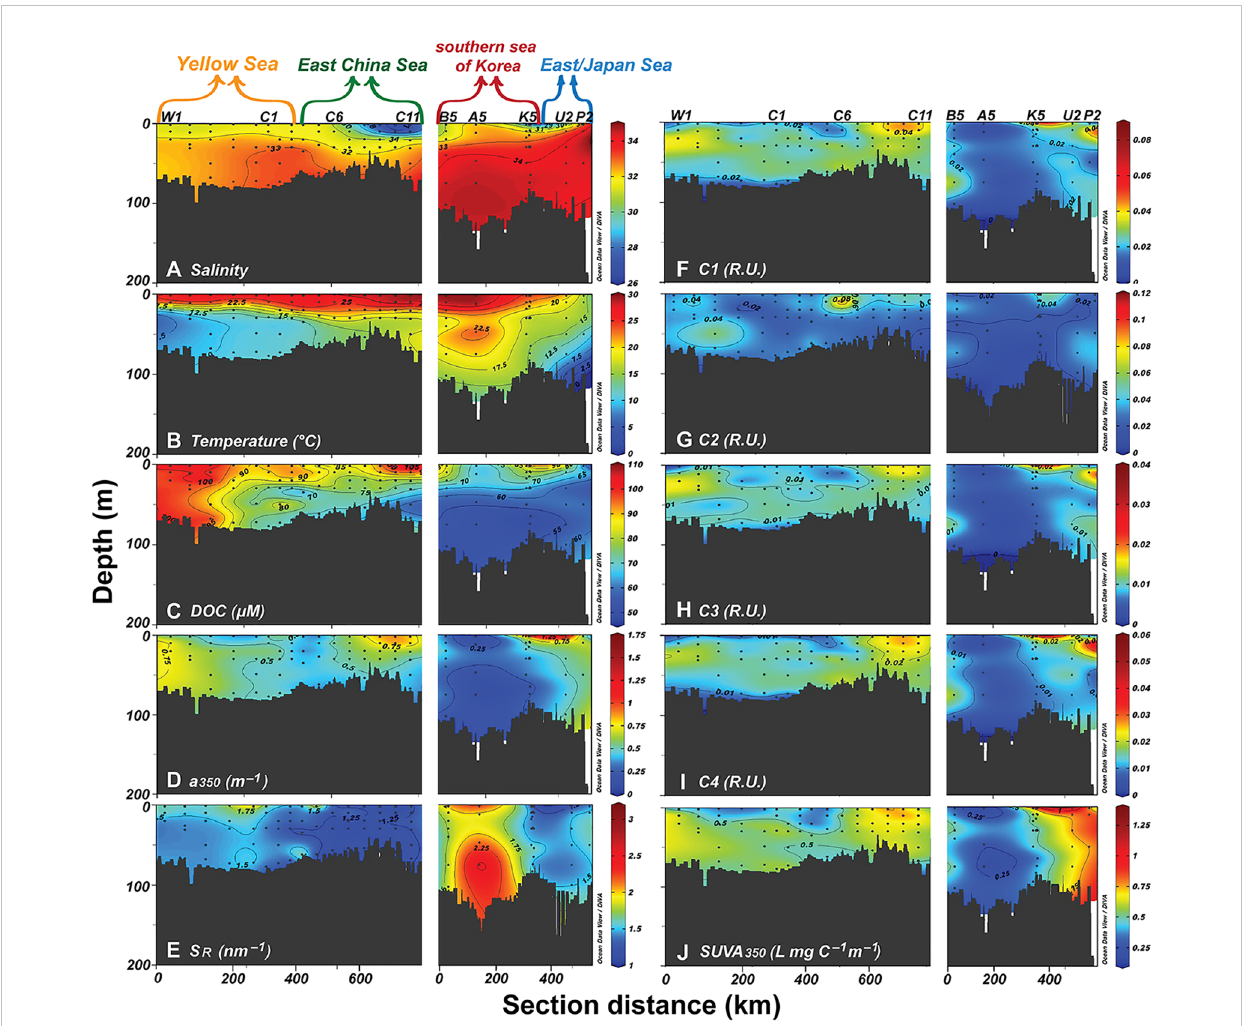
FIGURE 3 Sectional distributions of salinity (A) , temperature (B) , DOC concentrations (C) , a 350 (D) , S R (E) , FDOM components (F – I) , and SUVA 350 (J) along the transect shown in Figure